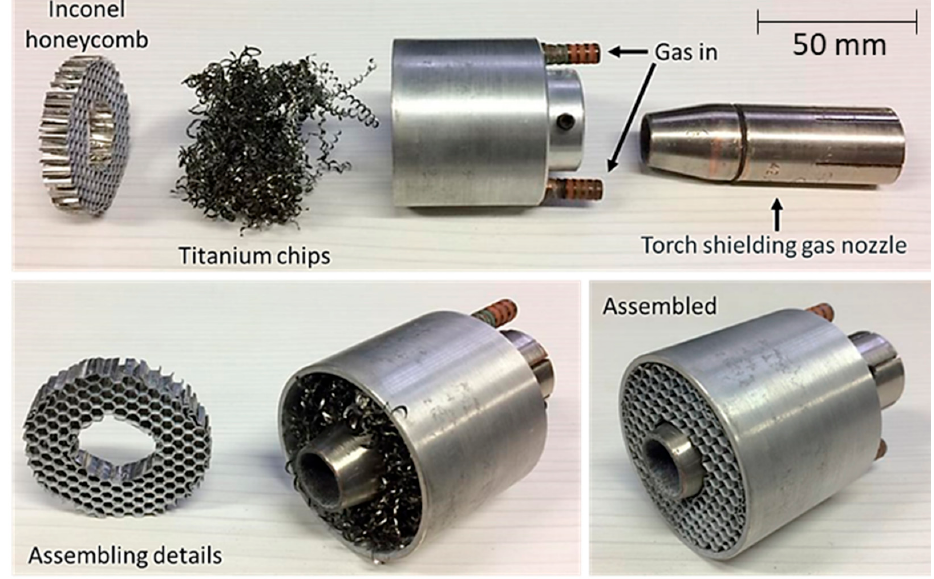
Figure 12. Supplementary shielding gas nozzle devised (Ø 50 mm) to mitigate excessive oxidation of the layer top